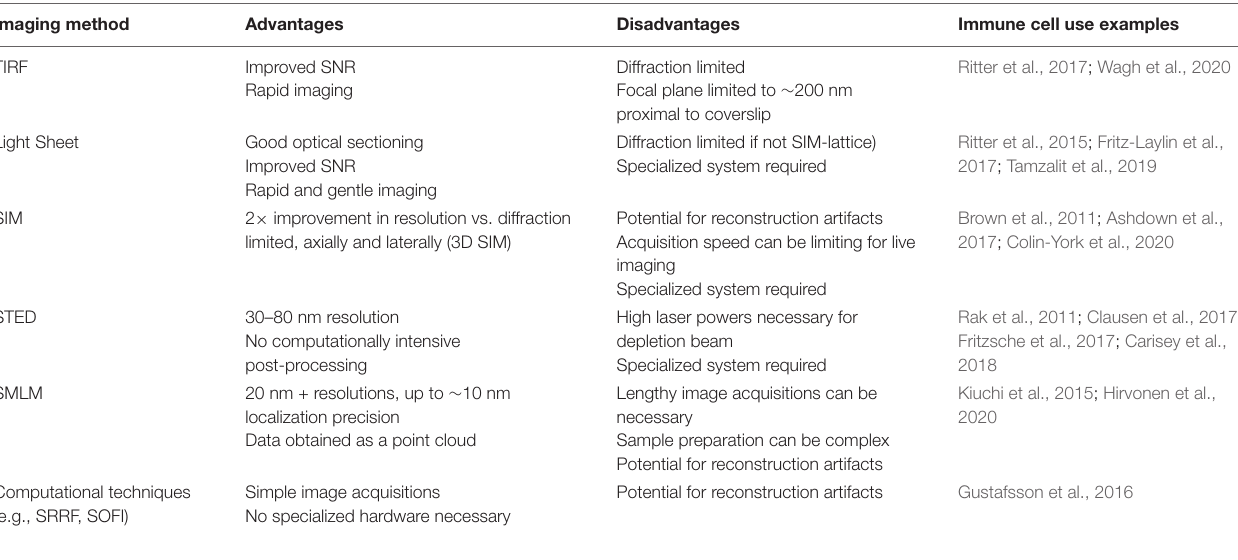
TABLE 2 | Summary of key microscope techniques applied to cytoskeletal imaging. Imaging